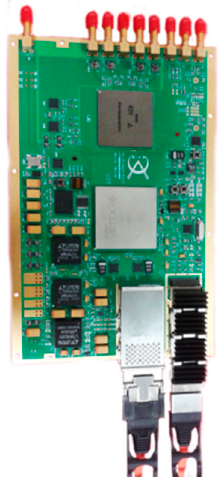
Figure 13. The digital receiver.